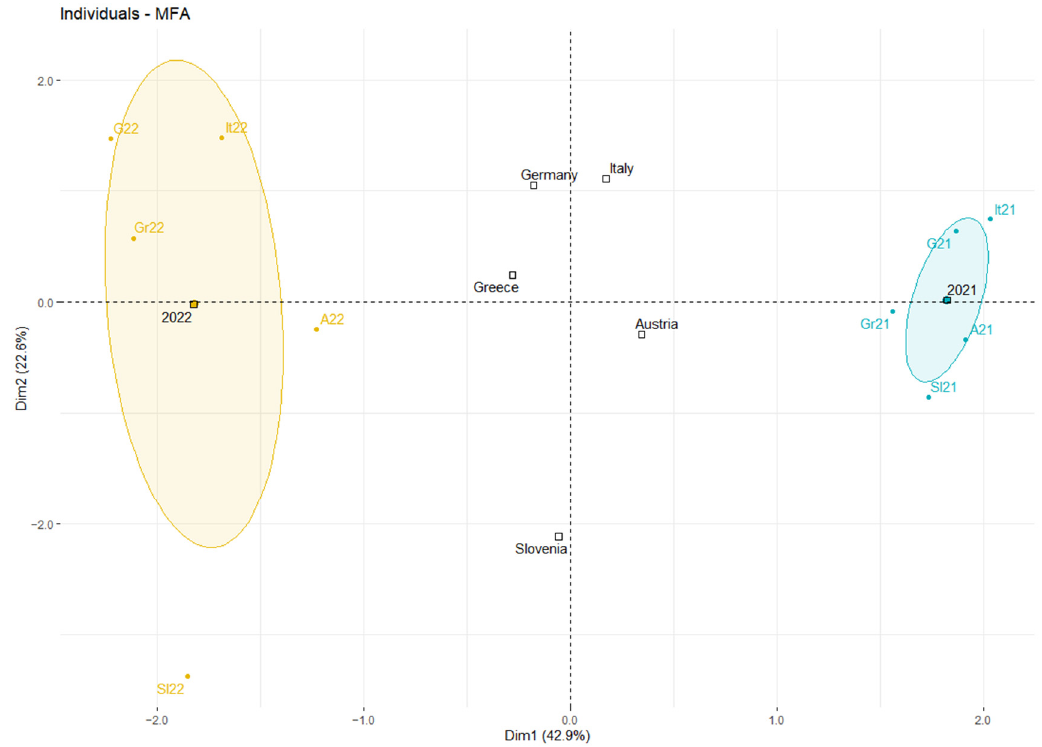
Figure 5. Individual results according to 2021 and 2022. It–Italy, G–Germany, Gr–Greece, A–Austria, Sl–Slovenia.